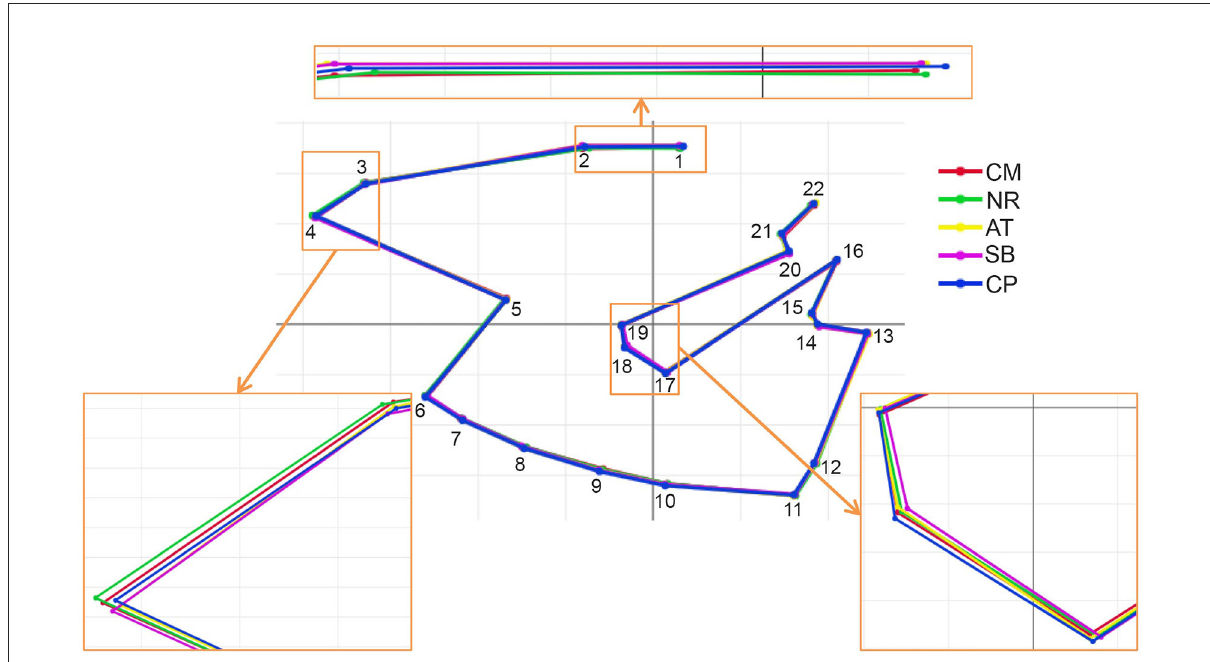
FIGURE5 Superposition of the mean shape landmark configurations of Tabanus rubidus among populations (CM, Chiang Mai; NR, Nakhon Ratchasima; AT, Uthai Thani; SB, Singburi; CP, Chumphon). Small frames show enlarged images of wing shape with variations.